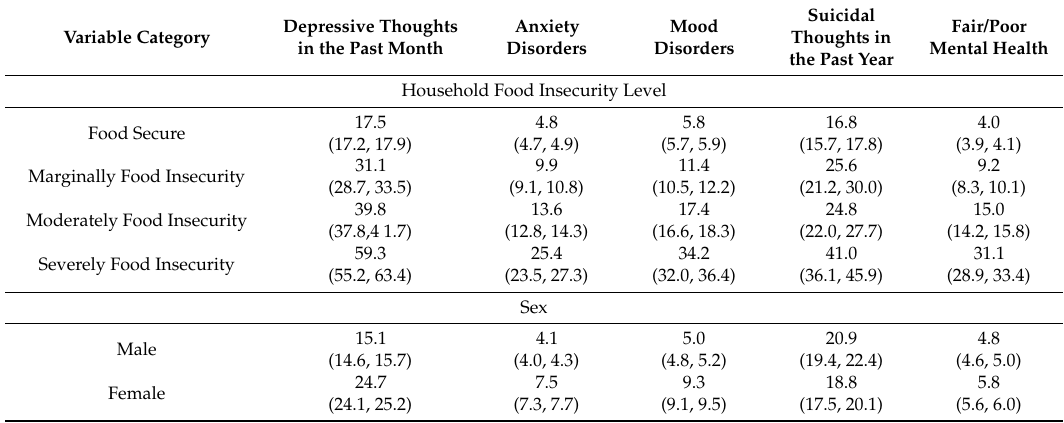
Table 2. Results from crude binary logistic regression of household food insecurity and by sex, separately, on five adverse mental health outcomes, presented as prevalence (%) and 95% confidence